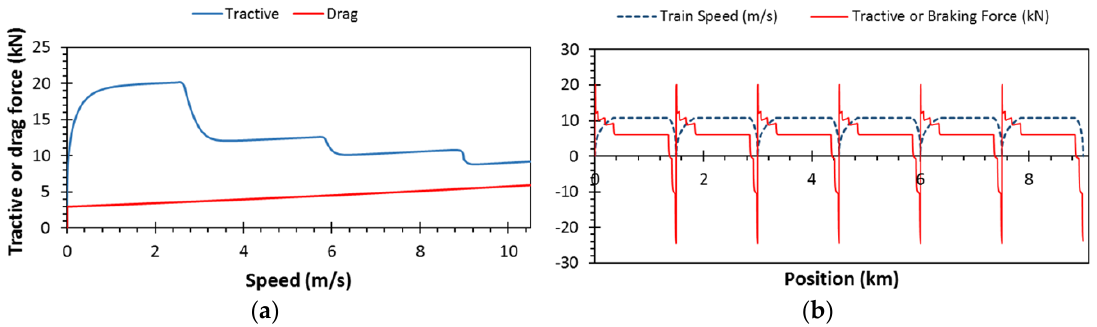
Figure 6. ( a ) The tractive and drag force of a single train; ( b ) Speed profile and tractive or braking force of a train for the entire journey on a single railway track.